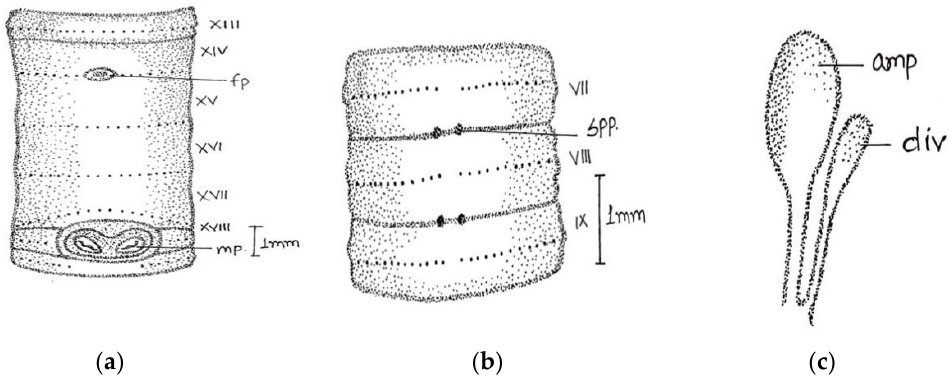
Figure 3. Camera lucida illustration of Megascolex cochinensis cochinensis ( a ) genital region; ( b ) sper- mathecal region; ( c ) spermathecae.